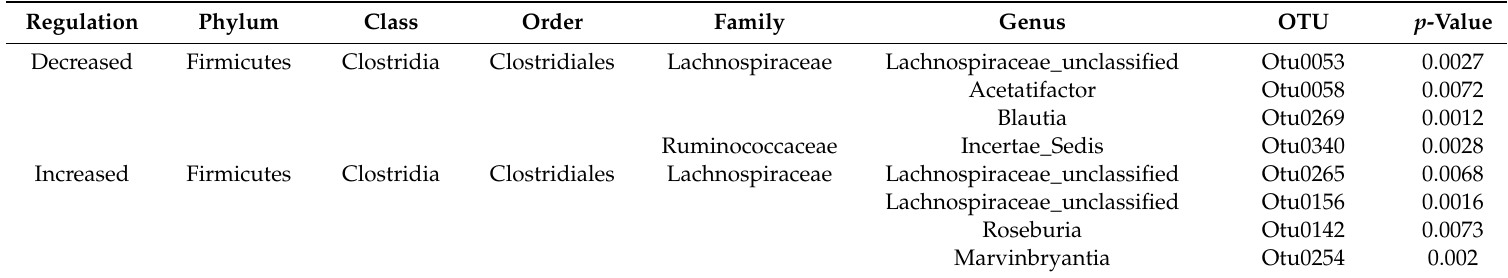
Table 3. OTU abundance significantly modified by BC a